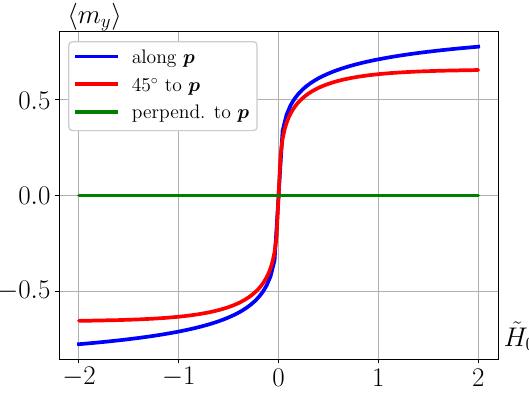
Figure 6. Curves of magnetization along the anisotropy axis. The case when the external field is directed along the anisotropy axis p (along the y axis) is denoted by the blue curve, at an angle 45 ◦ to the axis of anisotropy p —by the red curve and perpendicular to the anisotropy axis p (along the x axis)—by the green curve. From these figures it is evident that the magnetic susceptibility (slope of the curve) is the greater, the smaller is the angle between the axis of anisotropy and the direction of the applied magnetic field. The hysteresis–free magnetization curve obtained for the examined material under the action of the external field directed along the anisotropy axis (blue curve), agrees well with the weakly hysteretic experimental curve given in